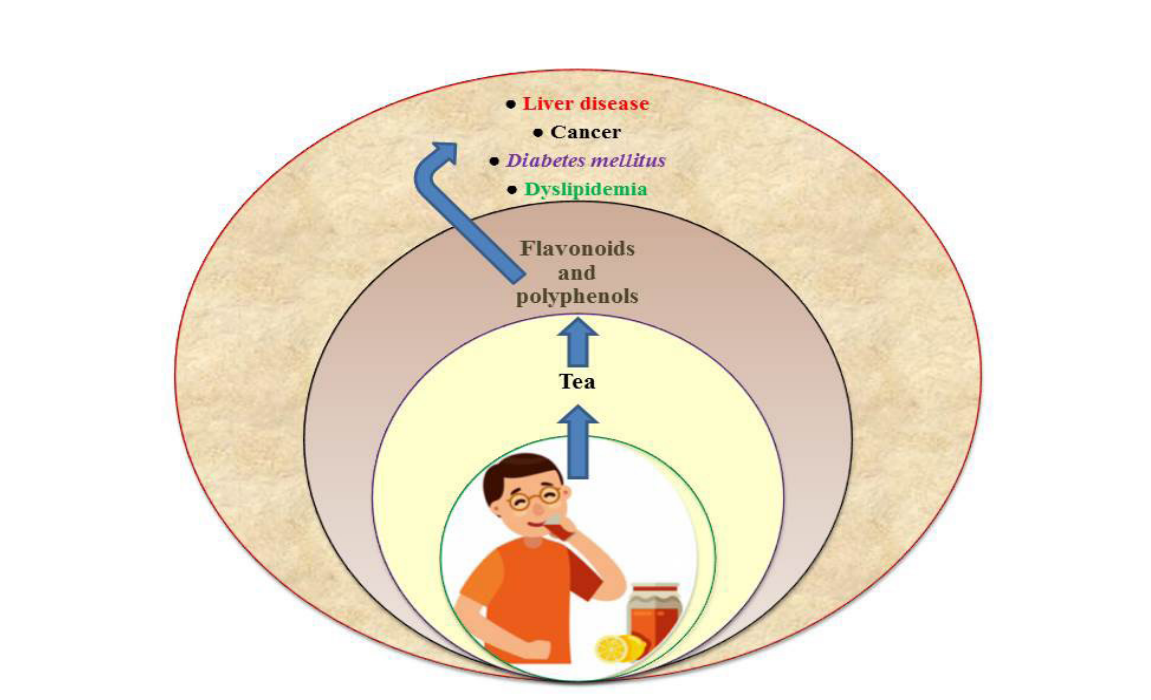
FIGURE 2 - Effect of kombucha consumption on the treatment of